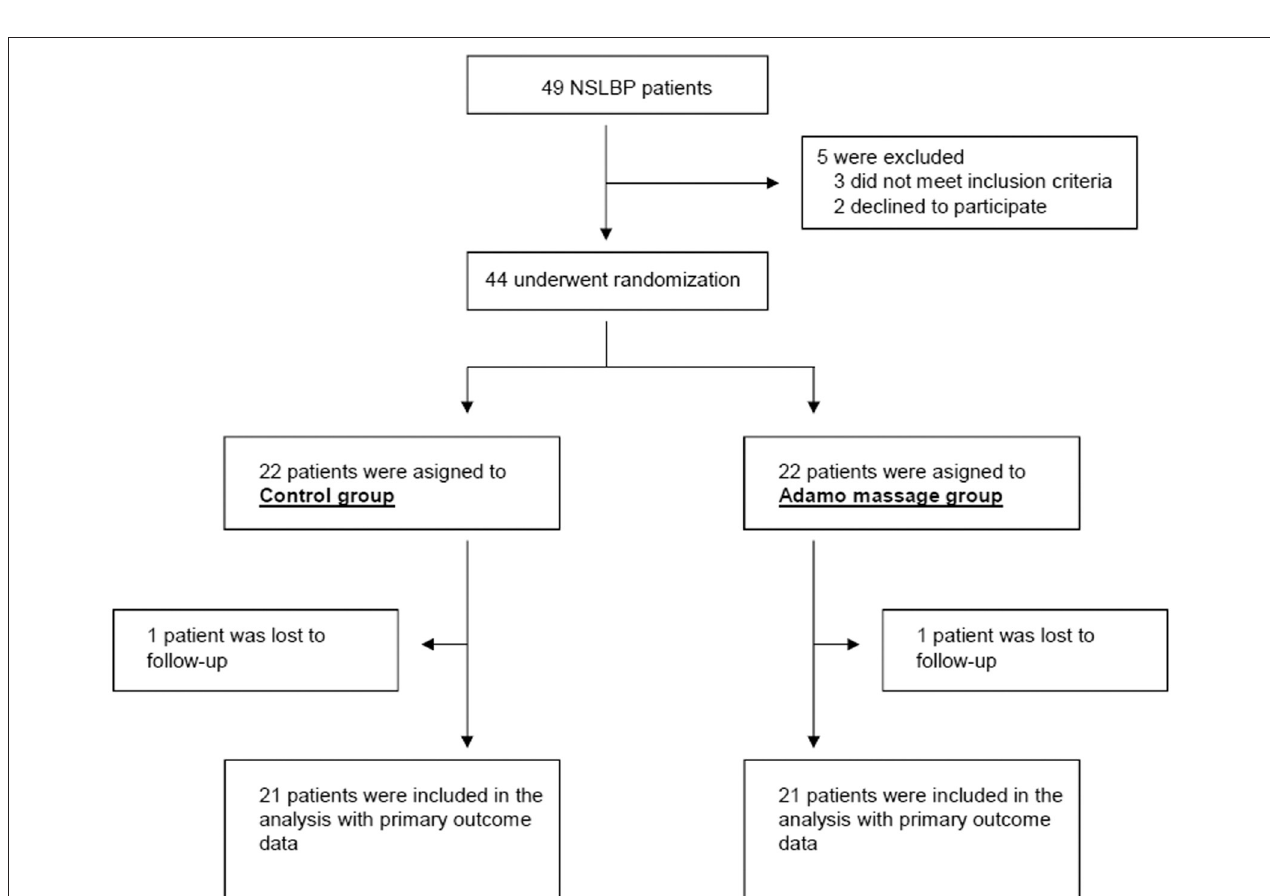
FIGURE 2 | Consort flow diagram of participants through the study.